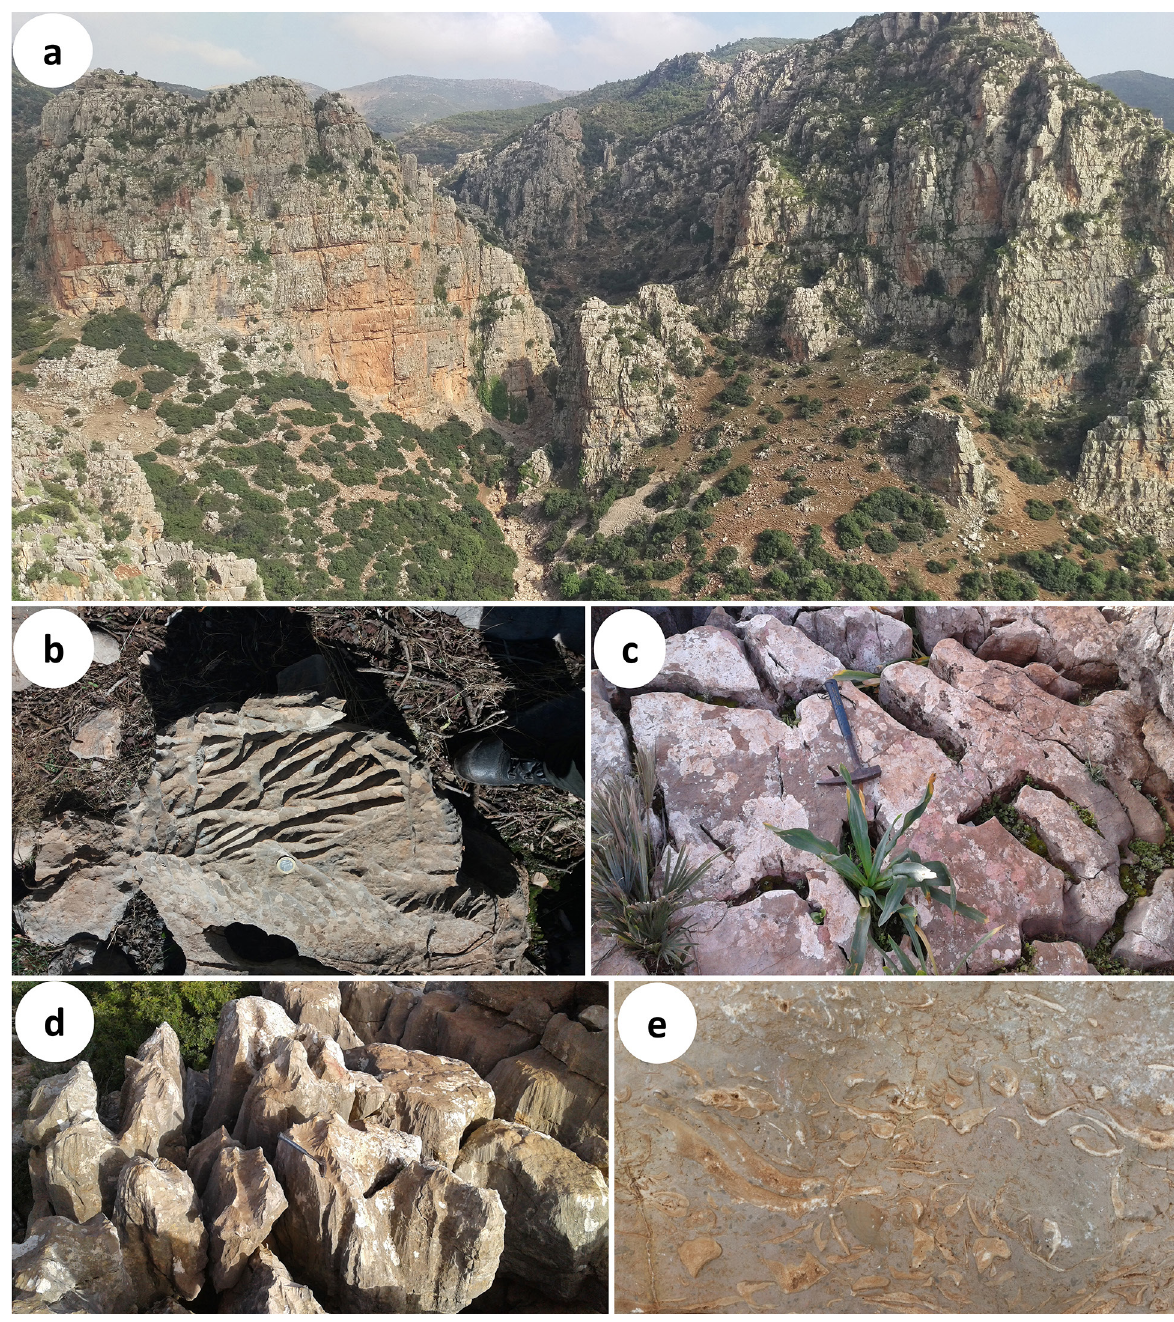
Fig. 11. Cliffs and karren of